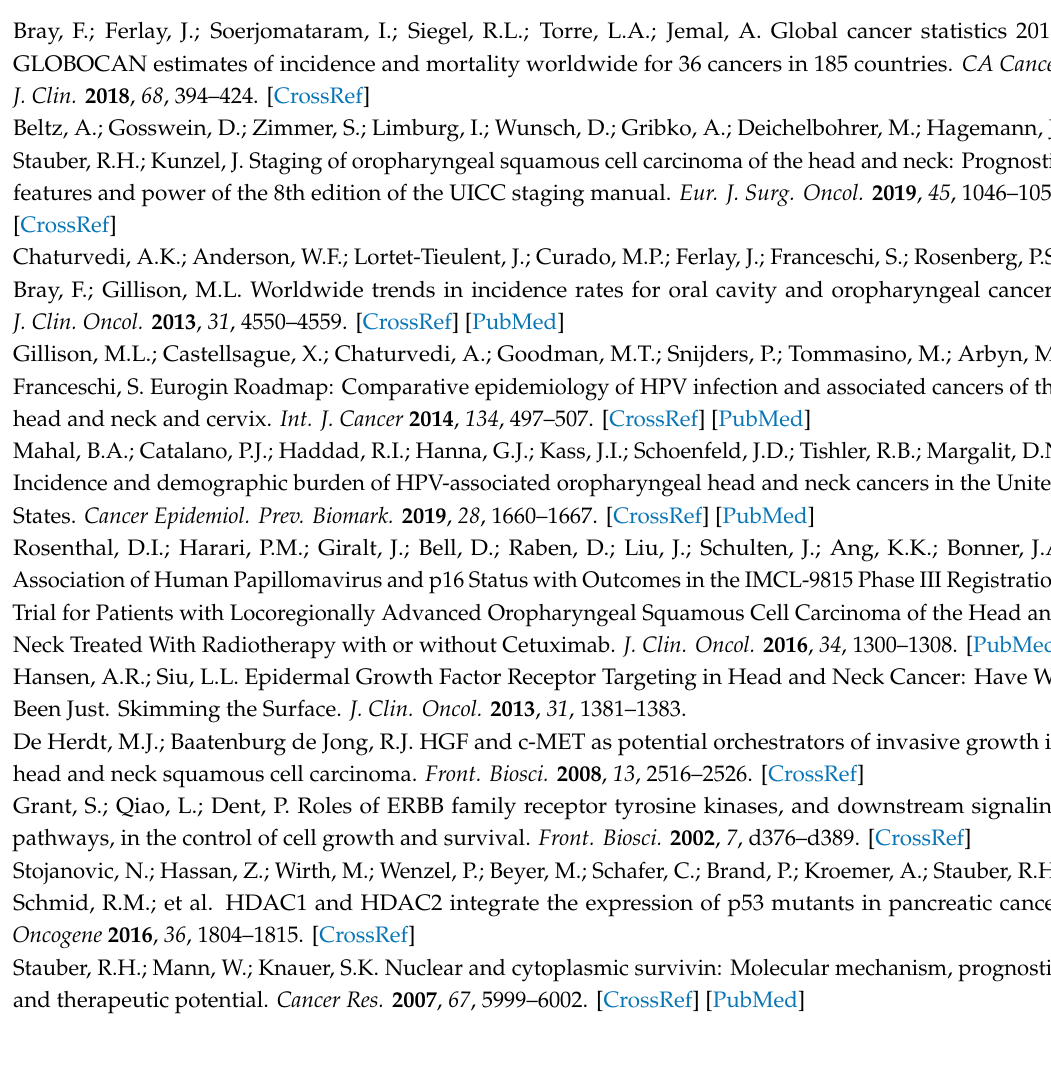
Figure S1 (a–f): Kaplan–Meier curves for prognostic impact of EGFR-, Her2-, Her3-, membranous or nuclear Her4- and c-Met expression on five-year overall survival. Figure S2 (a–f): Kaplan–Meier curves for prognostic impact of EGFR-, Her2-, Her3-, membranous or nuclear Her4- and c-Met expression on five-year disease-free